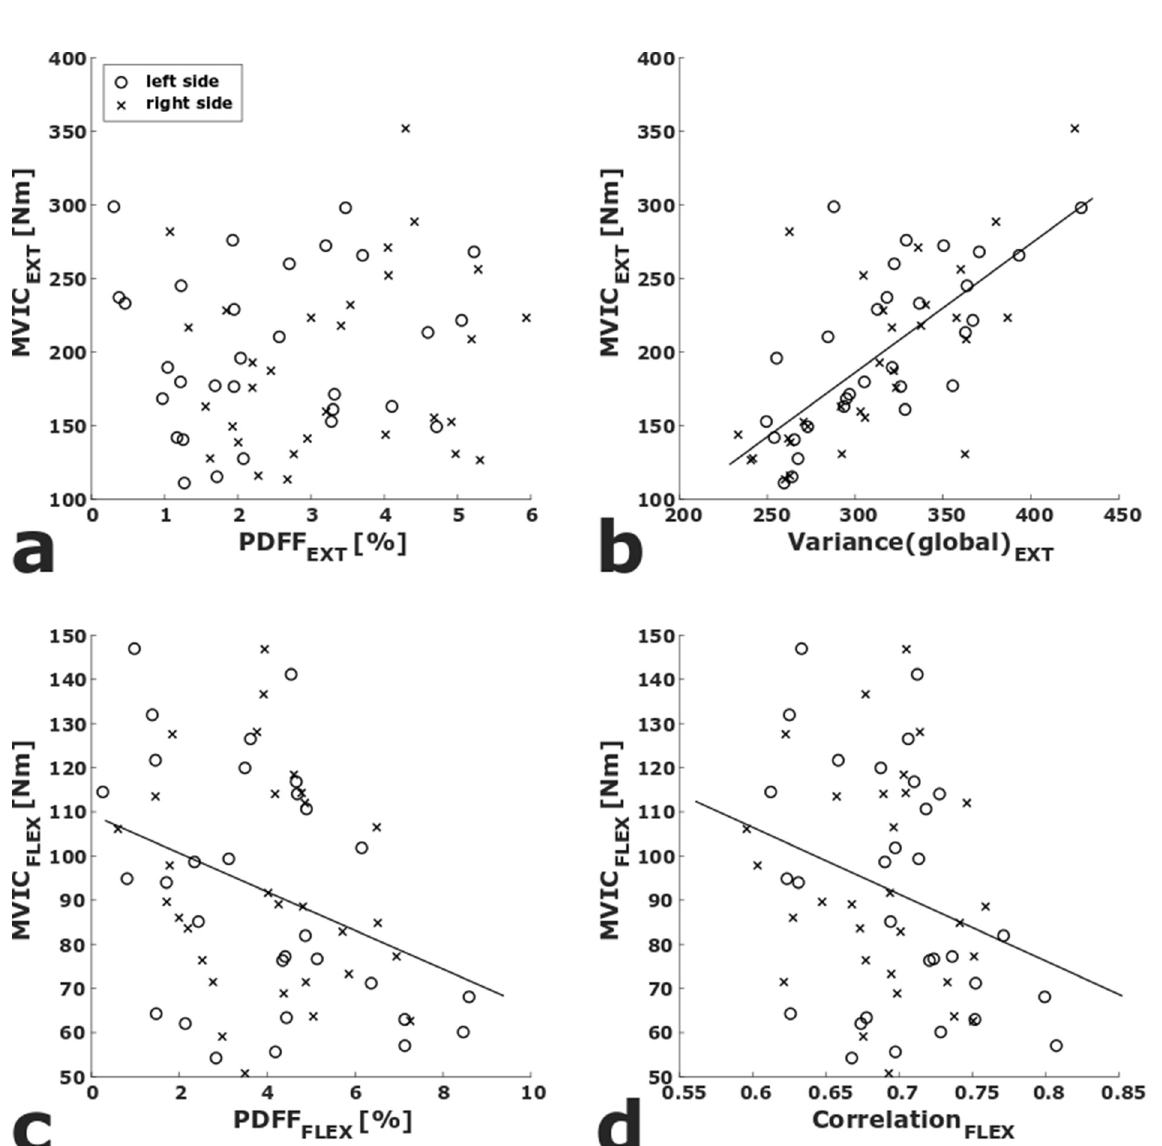
Figure 3. Scatter plots of PDFF EXT vs. MVIC EXT ( a ) and PDFF FLEX vs. MVIC FLEX ( c ). Scatter plots of the texture parameters with the highest R 2adj in the multiple adjusted linear regression analyses (Variance(global) EXT , Correlation FLEX ) vs. MVIC EXT ( b ) and MVIC FLEX ( d ). Linear regression lines are displayed for significant correlations. (PDFF EXT/FLEX , proton density fat fraction of quadriceps/ischiocrural muscles; MVIC EXT/FLEX maximum voluntary isometric contraction of quadriceps/ischiocrural muscles).